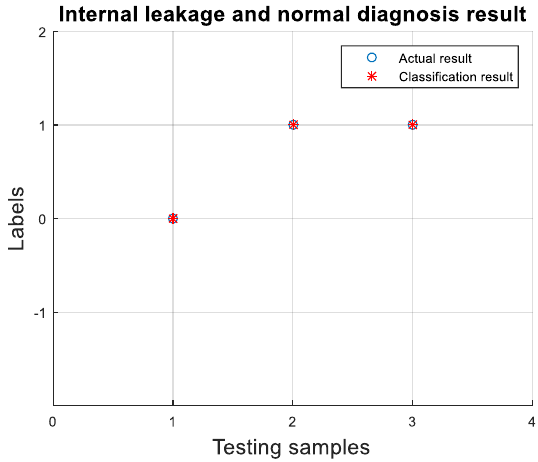
Figure 8. Relay valve internal leakage and normal diagnosis result.